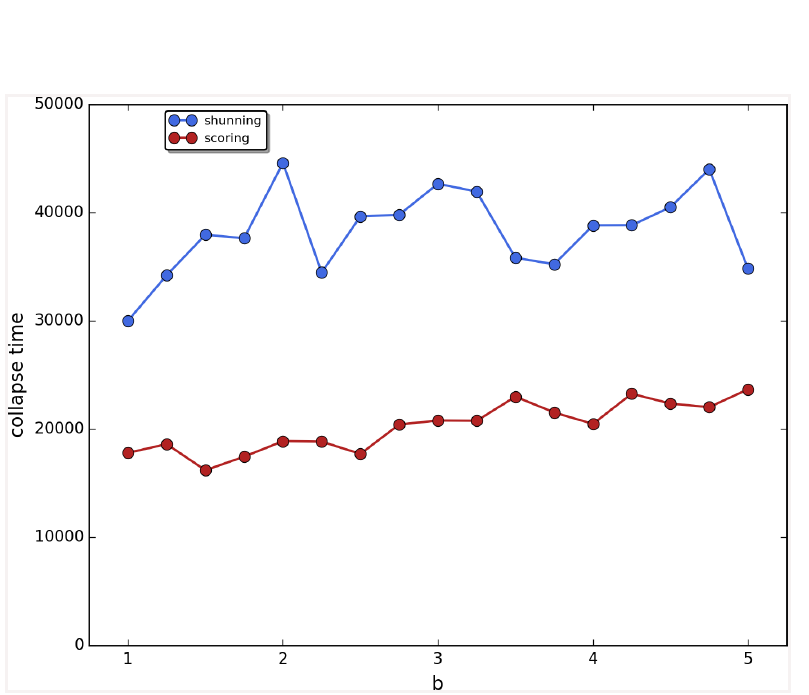
Fig 6. The average time elapsed till the collapse of cooperation, BETA6. The figure shows the average time until the collapse of cooperation as a function of the value of the benefit ( b ) for different social norms in the third scenario (BETA6). Each symbol represents the average of 100 runs, parameters are as follows: n = 100, c = 1, α = 1, β = 6, MST = 80%.